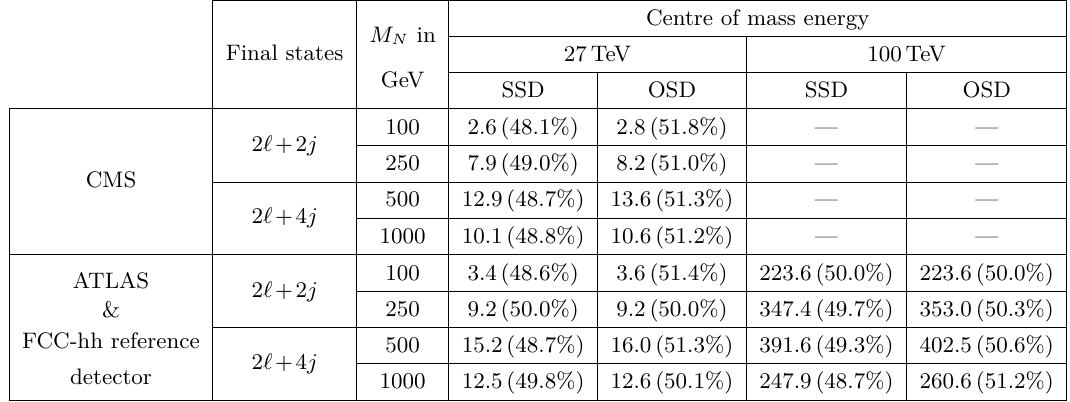
Table 18. Number of events containing SSD or OSD and their percentage numbers (in bracket) for different RHN masses ( M in GeV) with the centre of mass energies of 27, 100 TeV, at N